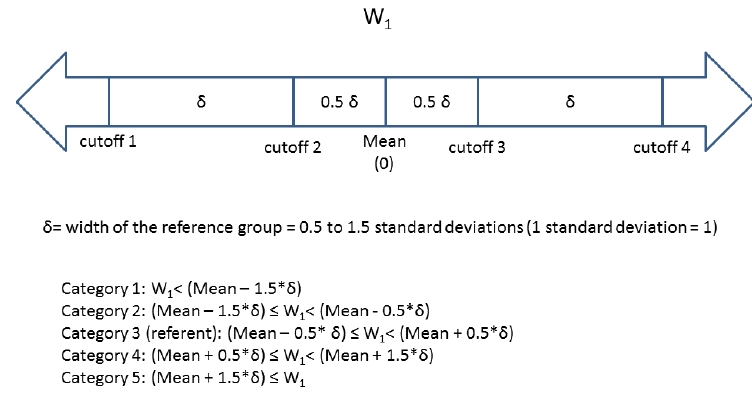
Figure 1. Descriptions of four cutoffs and five categories for W 1